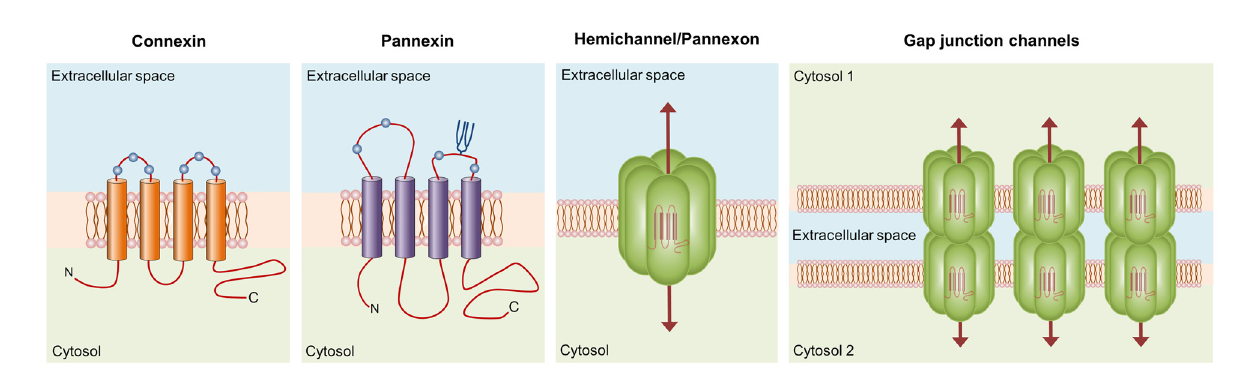
FIGURE 1 | Basic structure of connexin and pannexin-based channels. Connexins and pannexins share a similar membrane topology with four α -helical transmembrane domains connected by two extracellular loops and one cytoplasmic loop; both the amino- and carboxy-termini are intracellular. The relative positions of the extracellular loop cysteines (green balls) and glycosylated asparagines (blue branches) are also shown. Hemichannels (also known as connexons) are formed by the oligomerization of six subunit connexins around a central pore. Pannexons are single membrane channels that are composed of six pannexin subunits. Recently, a band pattern more consistent with an octamer than a hexamer was observed in Panx2 by cross-linking studies and native gels of purified homomeric full-length and C-terminal truncation mutants (Ambrosi et al., 2010). Under resting conditions, hemichannels and pannexons remain preferentially closed, but they may be activated by diverse physiological and pathological conditions and offer a diffuse transmembrane route between the intra- and extracellular milieu. Hemichannels dock each other to form functional cell-to-cell channels termed gap junction channels (GJCs). GJCs aggregate in well-known anatomical structures called gap junctions to facilitate the intercellular cytoplasmic exchange of metabolites, second messengers and ions.